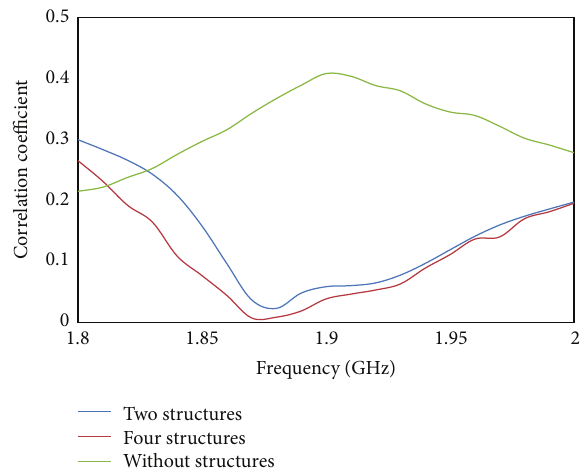
Figure 10: Correlation coefficient between two PIFAs without and with two slits or four slits.